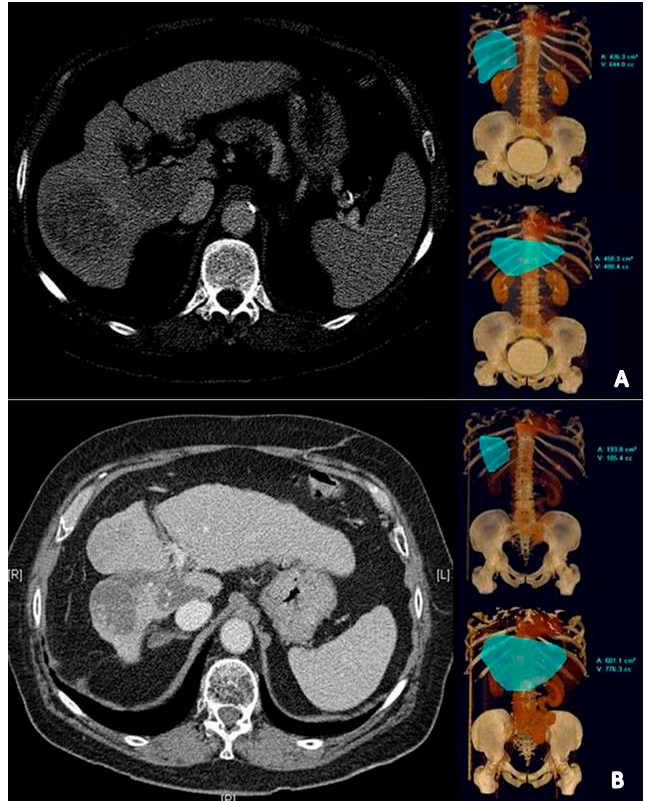
Figure 3. Pre- and post-treatment radiation lobectomy imaging. ( A ) Pre-treatment arterial phase contrast-enhanced CT showing multifocal right lobe HCC. Pre-treatment right and left HLVs are 644 and 498 mL, respectively. ( B ) Post-treatment contrast-enhanced CT demonstrates right lobe atrophy, tumor necrosis, and left lobe hypertrophy. Post-treatment HLVs are 185 mL and 776 mL, respectively. Reproduced with permission from [49].